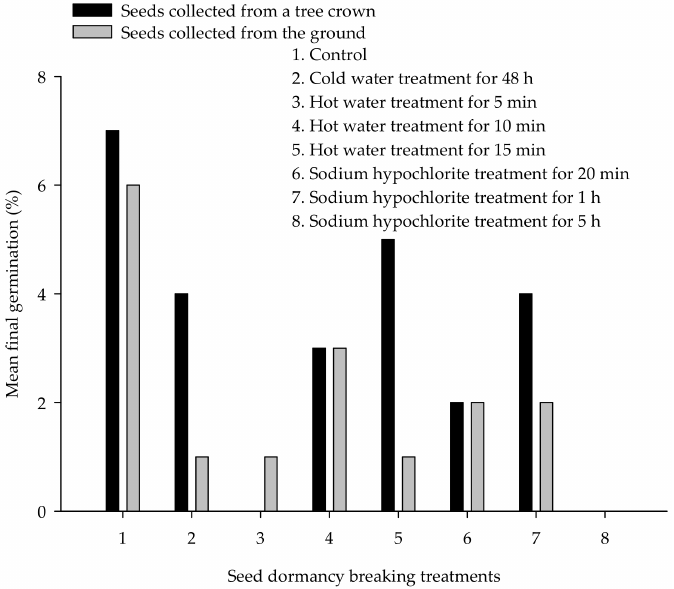
Figure 4. Final germination percentage of D. steudneri seeds collected from the tree and the ground with different presowing treatments in the